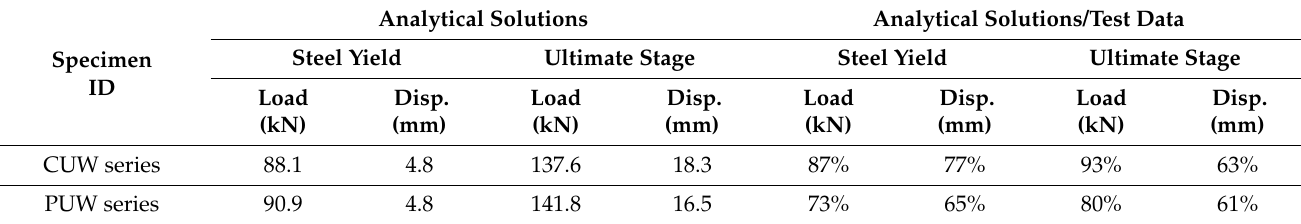
Table 9. Comparison of test data and analytical solutions.